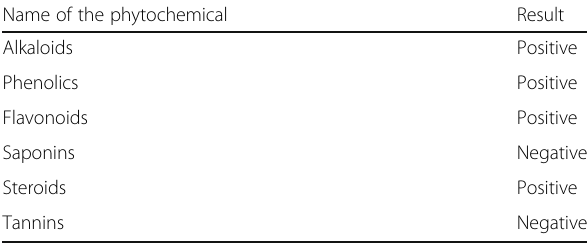
Table 4 Phytochemical analysis showing positive results for alkaloids, flavonoids, and steroids. In contrast, our study also indicates the absence of saponins and tannins in the sample